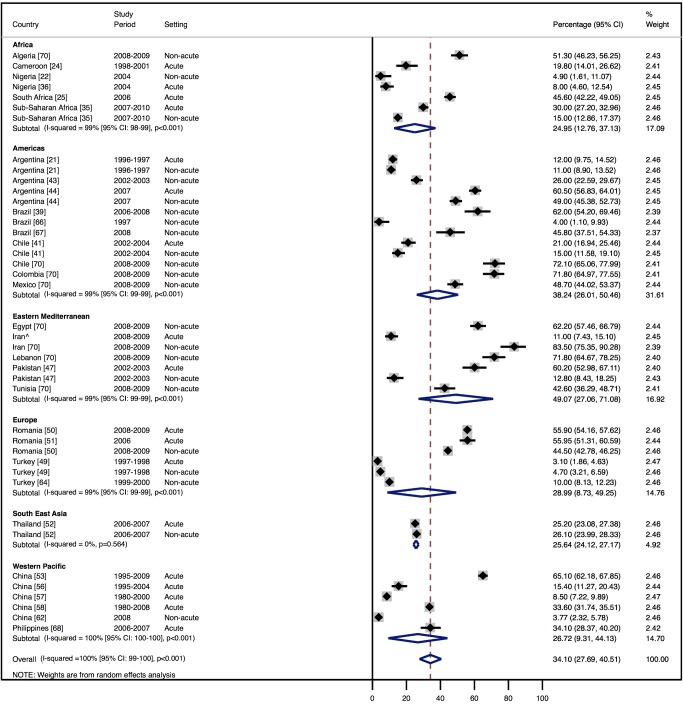
Beta-blocker use by region.∧Rahimzadeh S, Farzadfar F, Ghaziani M (2013) Iranian hospital data project (unpublished data).